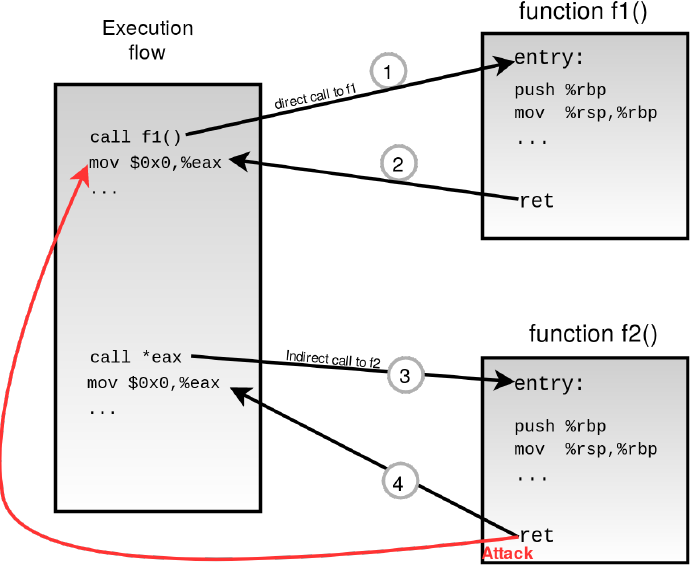
Figure 1. Fine-grained CFI approach bypass example. The attacker can successfully redirect (arrow in red) the control flow from the ret instruction in step 4 to the mov instruction next to call f1() .